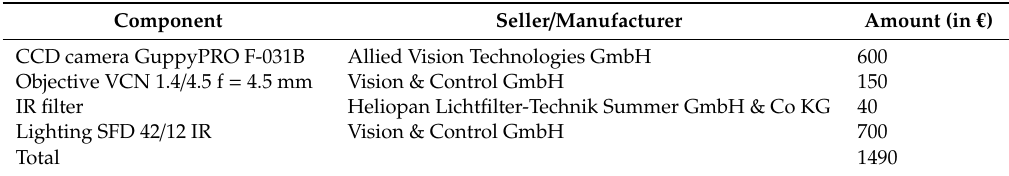
Table 2. Estimated prices of the proposed scanner